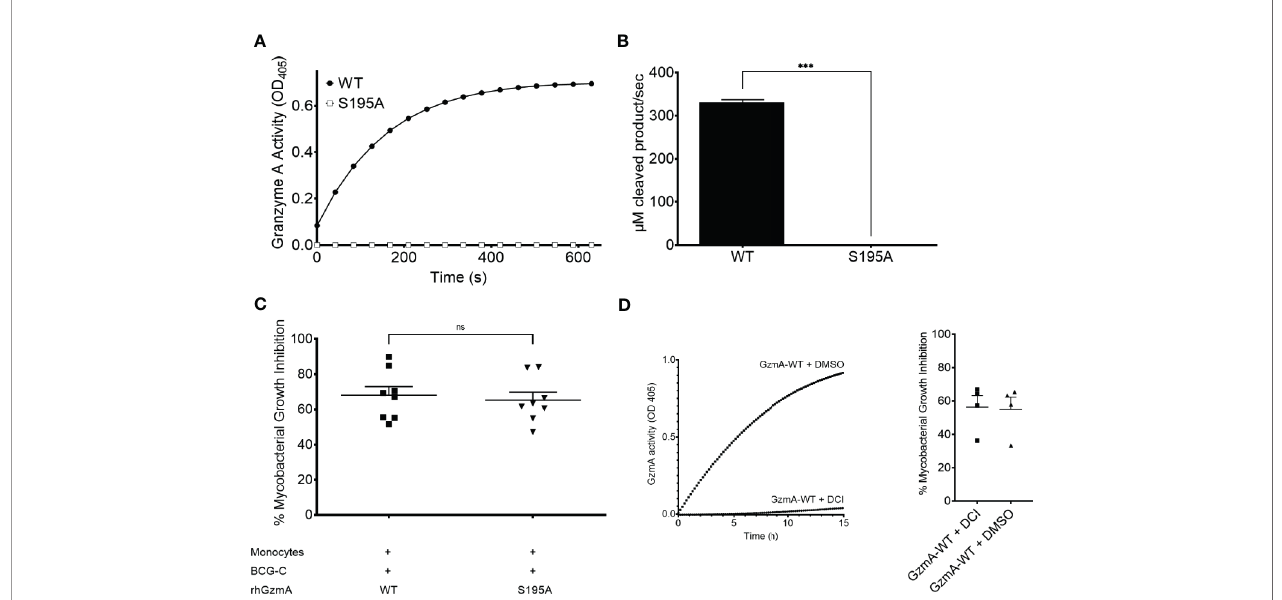
FIGURE 2 | Enzymatic activity is dispensable to mediate mycobacterial growth inhibition. (A) GzmA of wild-type (WT) and S195A variant proteins ’ activity over time measured by the BLT assay of three independent experiments performed as triplicates per condition. (B) For statistics, the rate of initial reaction was compared between WT and S195A variant (means and SD; paired t-test). (C) MGIA comparing WT and S195A enzymatically inactive variant, displayed as % of inhibition (n=8 in at least two independent experiments. Mean and SEM, Wilcoxon matched-pairs signed rank test). (D) GzmA treated with DCI inhibits intracellular replication as GzmA-DMSO in MGIA (left) and BLT assay (right) showing that inhibited GzmA retains inhibitory activity (n=4, Mean and SEM) (*p < 0.05, **p < 0.01, ***p < 0.001; ns, not signi fi